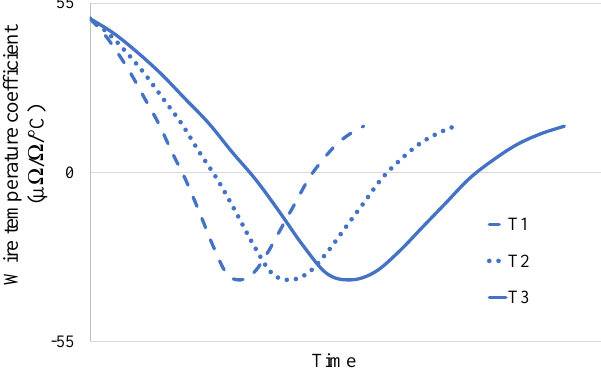
Figure 3. Graph of the change in Evanohm wire TC at temperatures T1 > T2 > T3. The time scale depends on the type of NiCr alloy wire and their